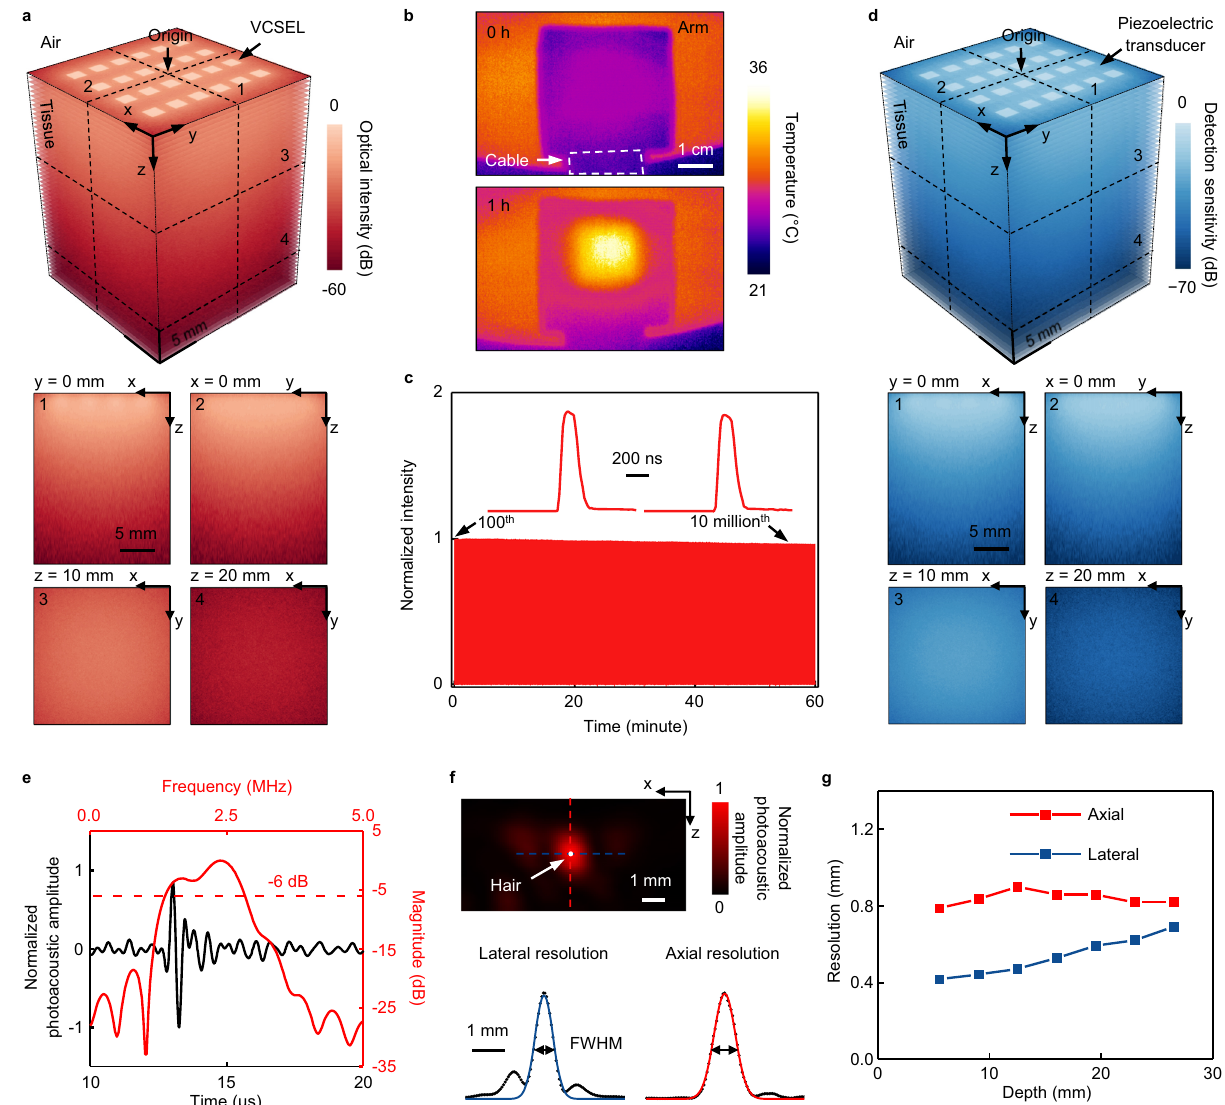
Fig. 2 | Characterizations of the soft photoacoustic patch. a Simulated optical intensity distribution in tissue. The 3D distribution map comprises 51 horizontal planes stacked together with display transparency of 60%. The four slices at the bottompanelhighlighttheopticalintensitydistributionatdifferentcross-sections. VCSEL: vertical-cavity surface-emitting laser. b Thermal imaging of the photo- acoustic patch on the arm immediately after turning on the lasers and after one hour of continuous operation. The maximum temperatureisbelow 36°C, whichis comfortable for long-term wear. c Testing of the VCSELs ’ output stability as they continuously work for 1h with a pulse duration of 200ns at a pulse repetition frequencyof3kHz.Theinsetscorrespondtothe100thandthe10millionthpulses. The decrease in normalized light intensity after an hour is <4%. d Simulated